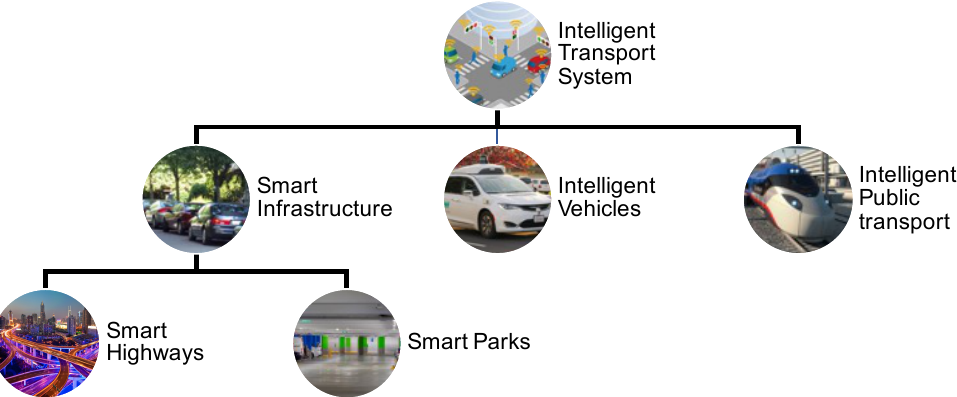
Figure 13. An overview of the intelligent transport systems, showing the main research areas, that is, smart infrastructure, intelligent vehicles, and intelligent public transport systems.